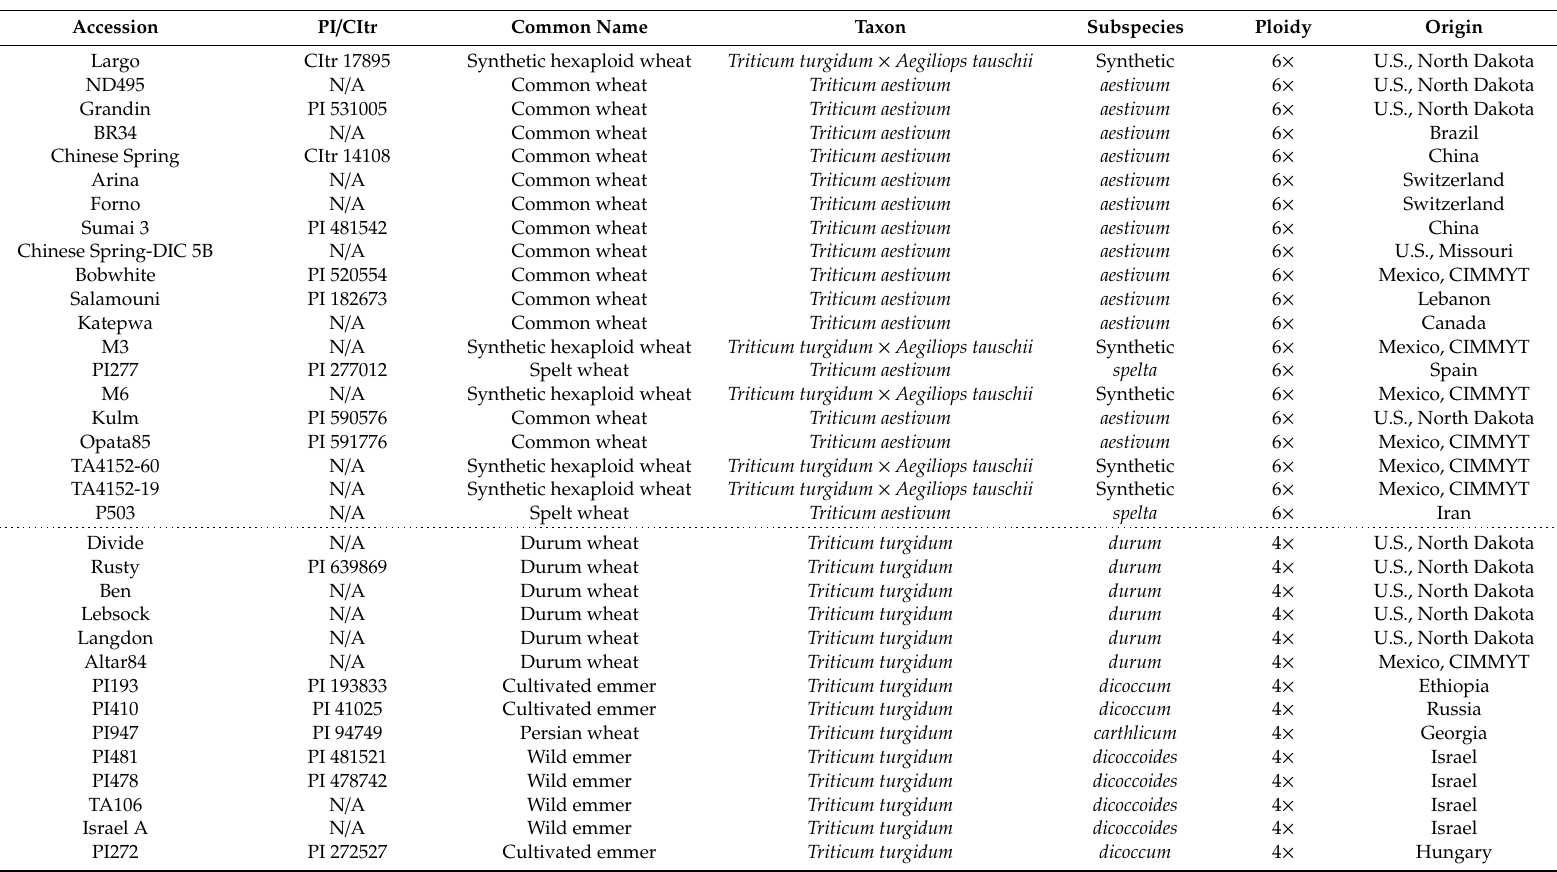
Table 1. The common name, taxonomy, origin, and source of 34 di ff erent accessions assessed for its seedlings root system architecture